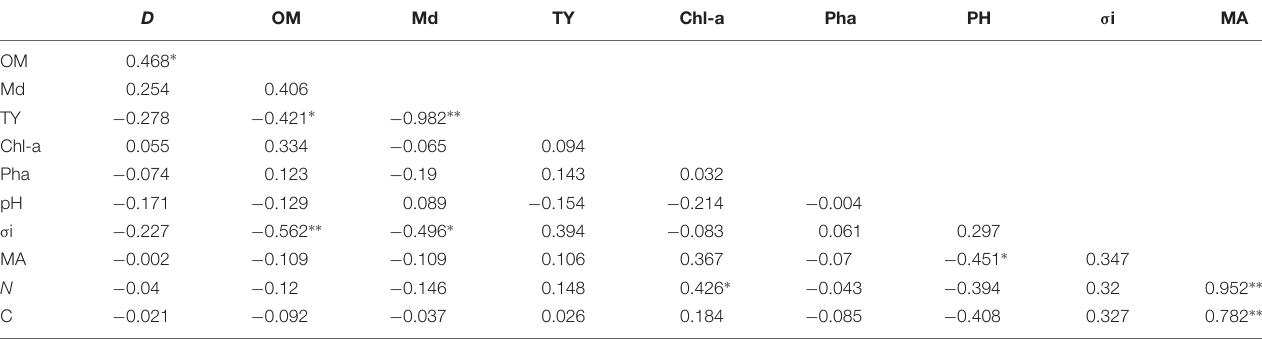
TABLE 4 | Correlation coefficient between abundance of Nematode meiofauna and environmental factors. D TY